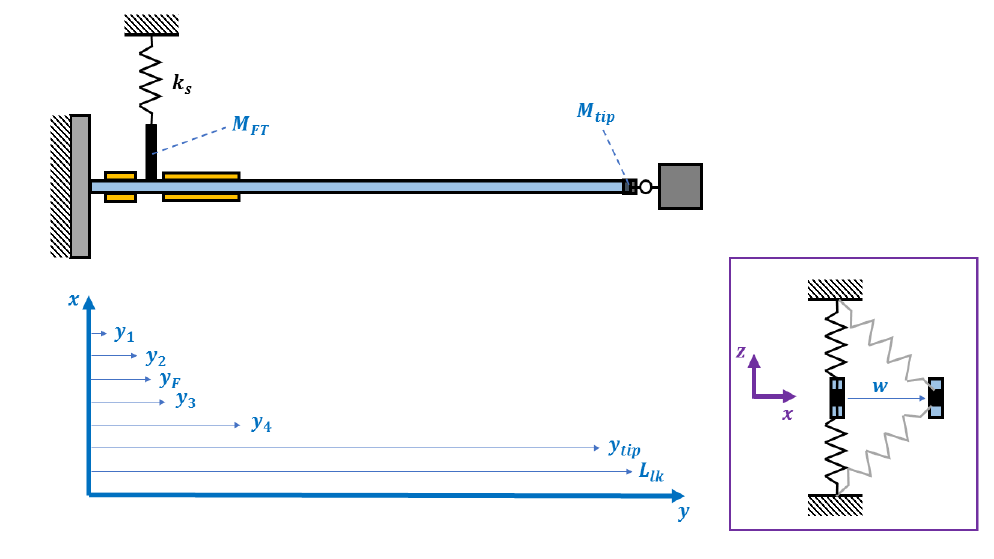
Figure 2. An illustration of the experimental set-up/analytical